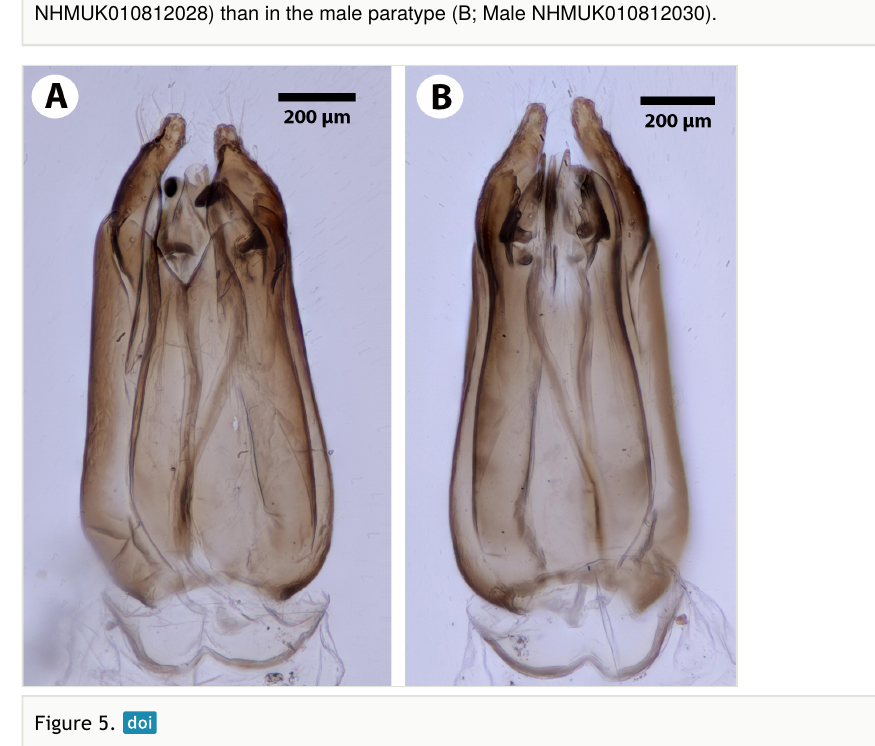
Figure 4. Antennae of the two known male specimens of Dendrocerus scutellaris , with arrows pointing to the variable eighth branch. The branch is more developed in the male holotype (A;